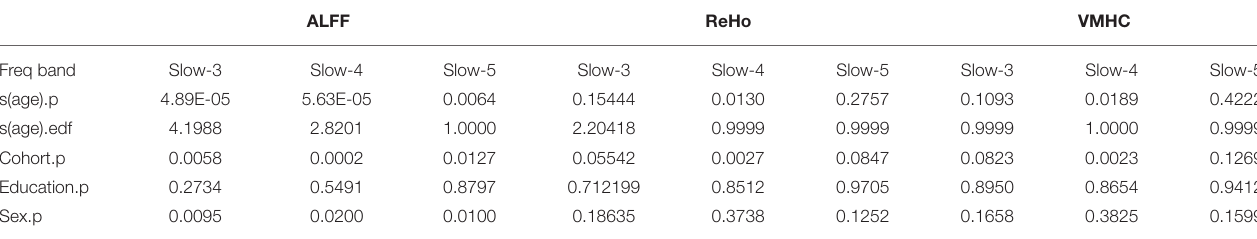
TABLE 1 | Generalized additive mixed models (GAMMs) on aging curve models for global mean measurements of cortical spontaneous activity (CSA). ALFF ReHo VMHC Freq band Slow-3 Slow-4 Slow-5 Slow-3 Slow-4 Slow-5 Slow-3 Slow-4 Slow-5 s(age).p 0.0058